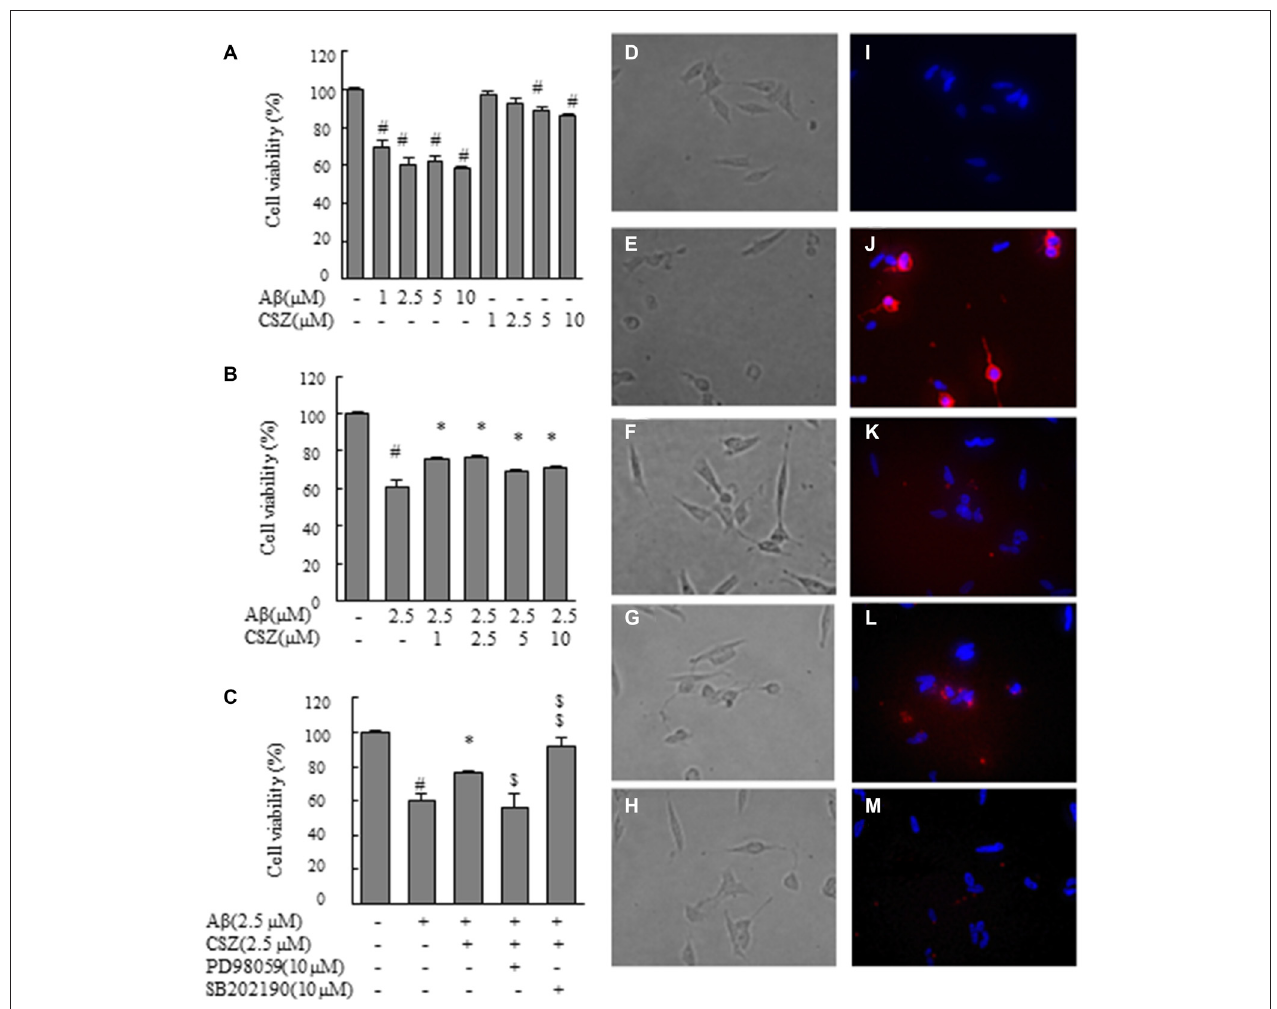
FIGURE 1 | Effect of cilostazol (CSZ) on viability and staining with annexin V and Hoechst33342 in amyloid β (A β )-stimulated SH-SY5Y cells. We evaluated the effect of A β on cell viability using MTT assay and stained with annexin V and Hoechst33342. (A) Cell viability of SH-SY5Y cells treated with A β and CSZ for 20 h. (B) The effect of A β with or without CSZ on cell viability of SH-SY5Y cells. (C) The effect of A β and CSZ with or without the inhibitor of MAPK/ERK kinase1/2 (MEK1/2) (PD98059) or p38 mitogen-activated protein kinases (MAPK) (SB202190) on cell viability of SH-SY5Y cells. Cells were observed under a phase-contrast microscope (D–H) and a fluorescence microscope (I–M) . Images (D,I) untreated SH-SY5Y cells; images (E,J) SH-SY5Y cells treated with A β ; and images (F,K) : SH-SY5Y cells treated with A β + CSZ; images (G,L) SH-SY5Y cells treated with A β + CSZ + inhibitor of MEK1/2; images (H,M) SH-SY5Y cells treated with A β + CSZ + inhibitor of p38 MAPK. Values are expressed as mean + SEM. # Compared vs. respective controls ( p < 0.01). ∗ Compared vs. A β -treated cells ( p < 0.05). $ Compared vs. A β + CSZ-treated cells ( p < 0.05). $$ Compared vs. A β + CSZ-treated cells ( p <